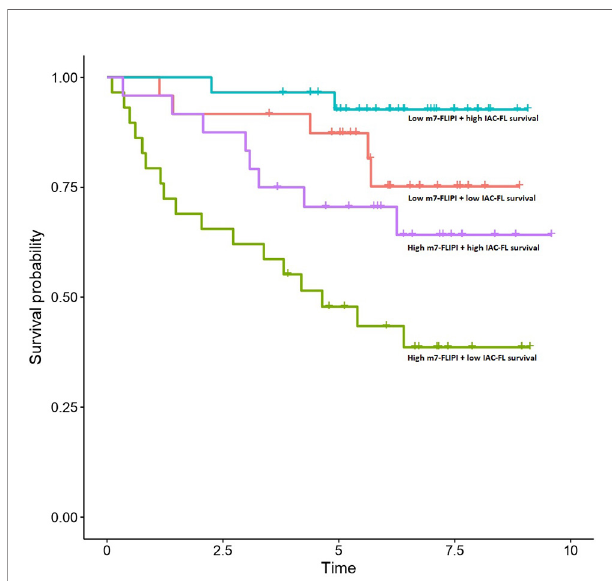
FIGURE 3 | Survival outcomes of patients in the test set according to m7- FLIPI and IAC-FL predictions at maximum follow-up. Patients are strati fi ed according to the medians of both